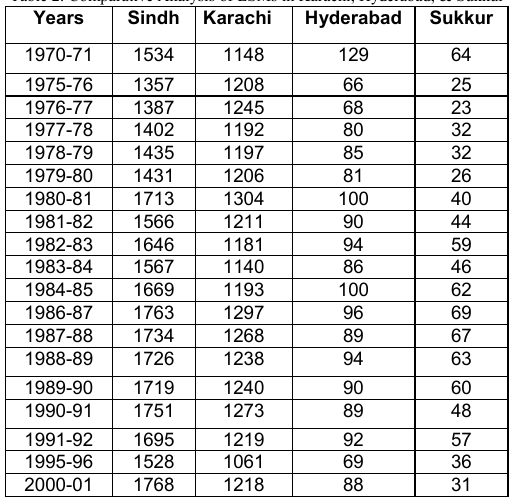
Table 2: Comparative Analysis of LSMs in Karachi, Hyderabad, & Sukkur